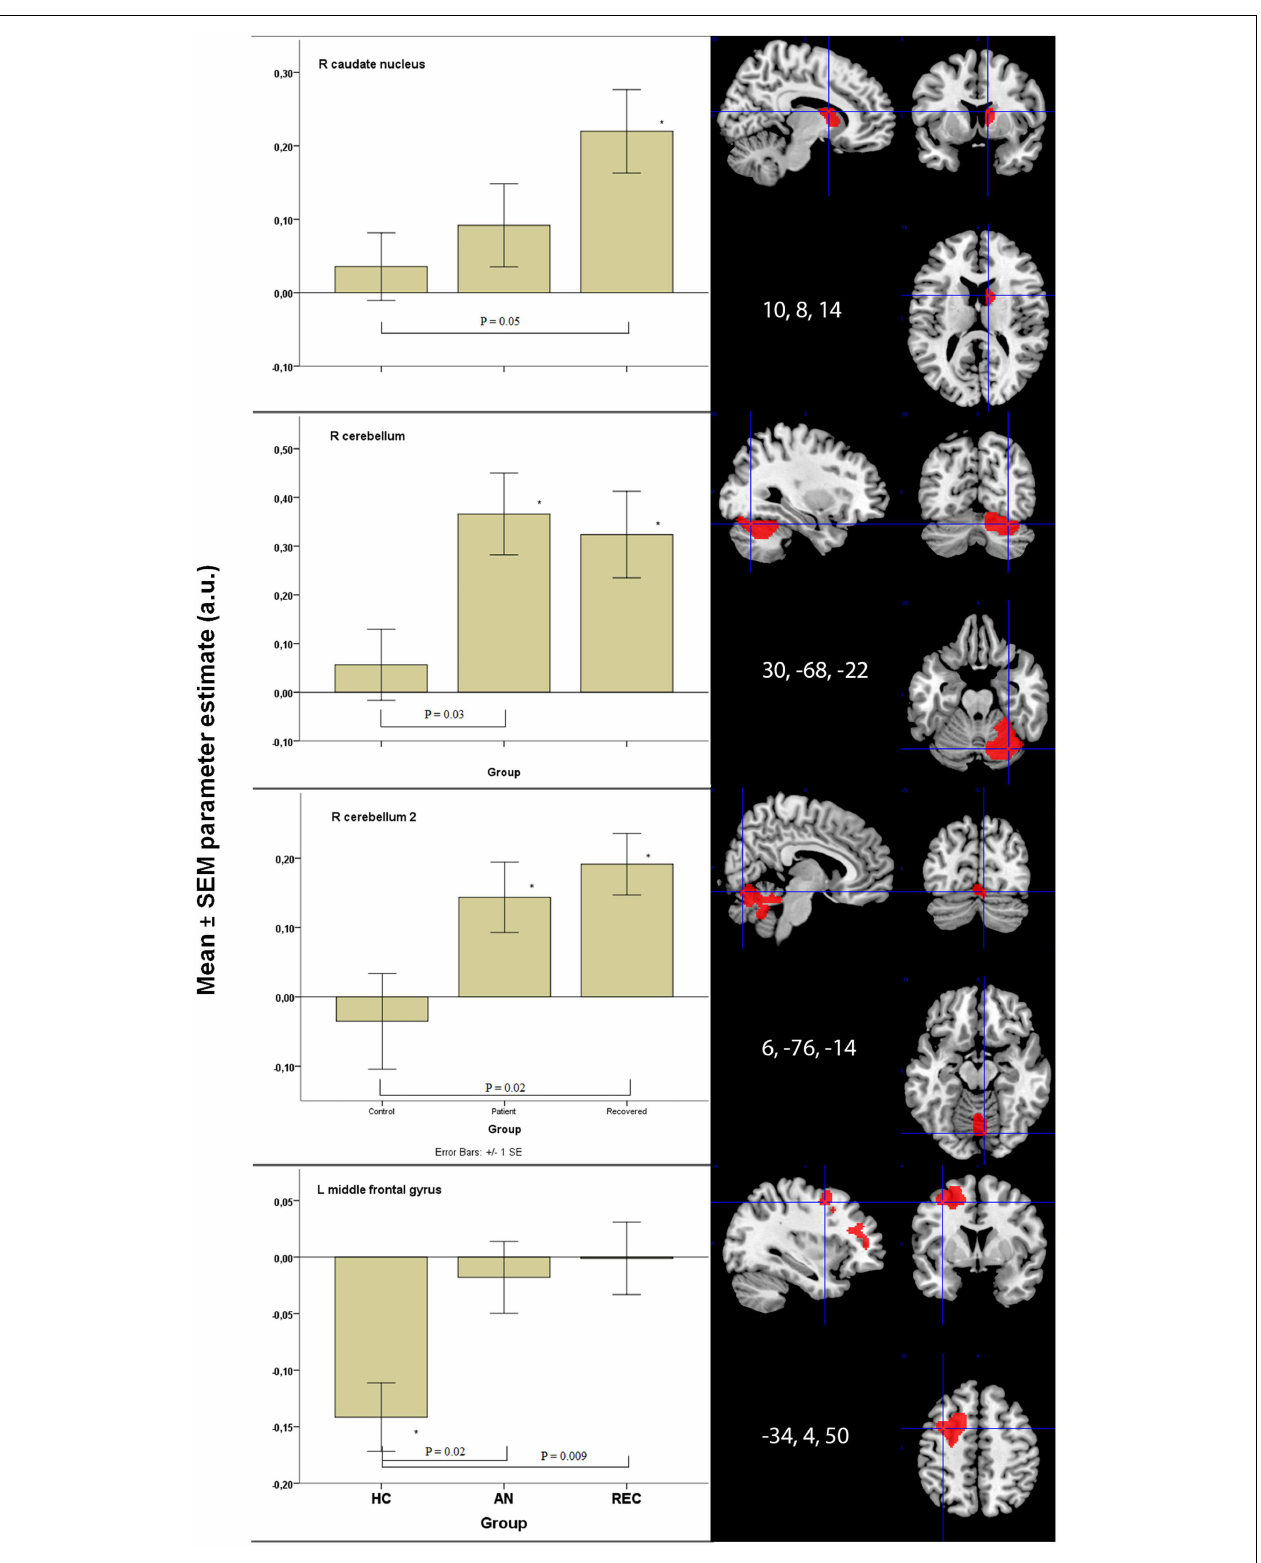
FIGURE 2 | Significant between group differences in food-cue activation results in bottom-up and top-down areas . * p < 0.05 when comparing food to non-food images. HC, healthy control; AN, anorexia nervosa; REC, recovered group; SEM, standard error of the mean; a.u., arbitrary